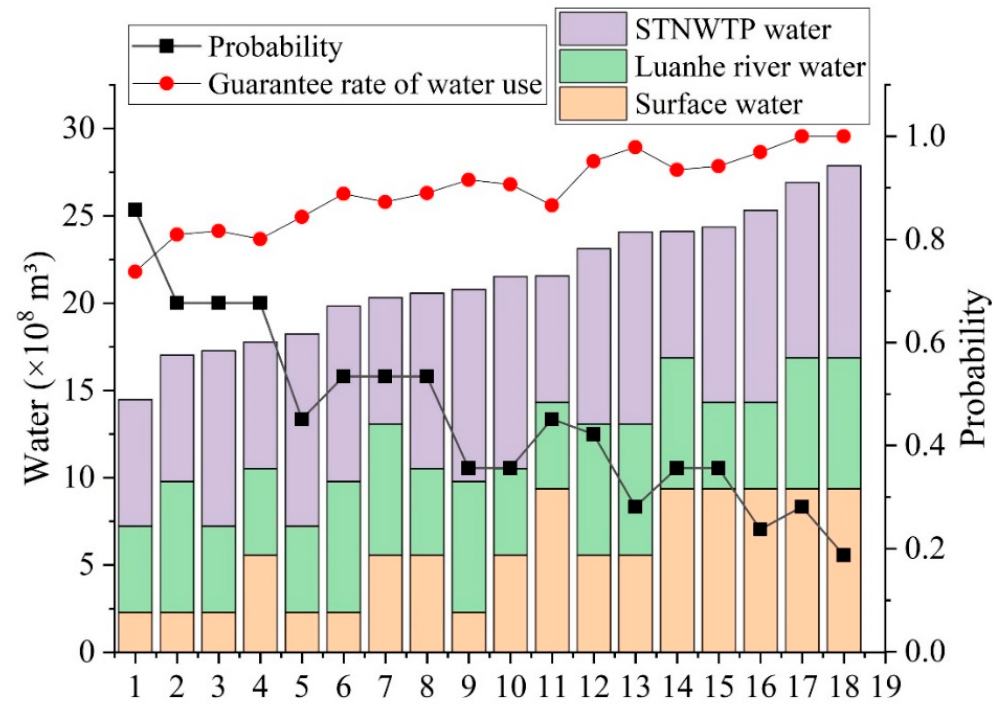
Figure 5. Eighteen schemes when both Luanhe river water and STNWTP water are used.